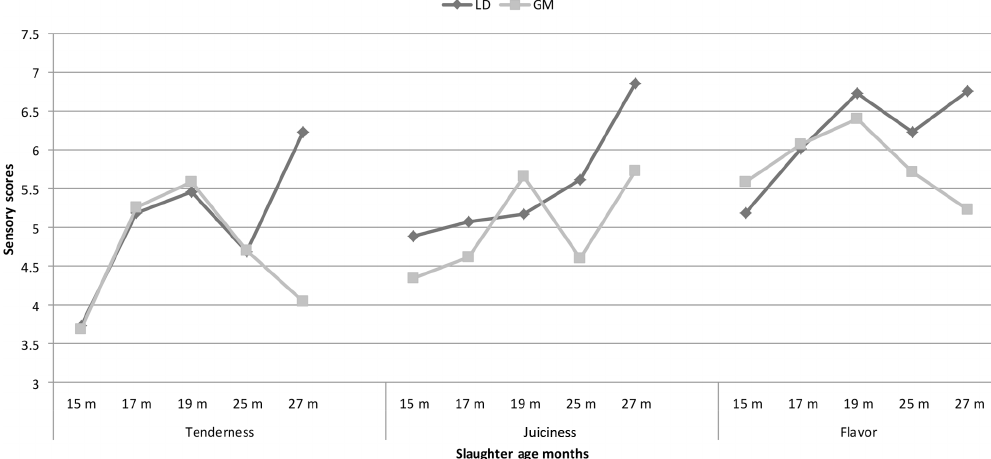
Figure 1. Changes in tenderness, juiciness and flavor scores of LD and GM muscles depending on the different slaughter age.